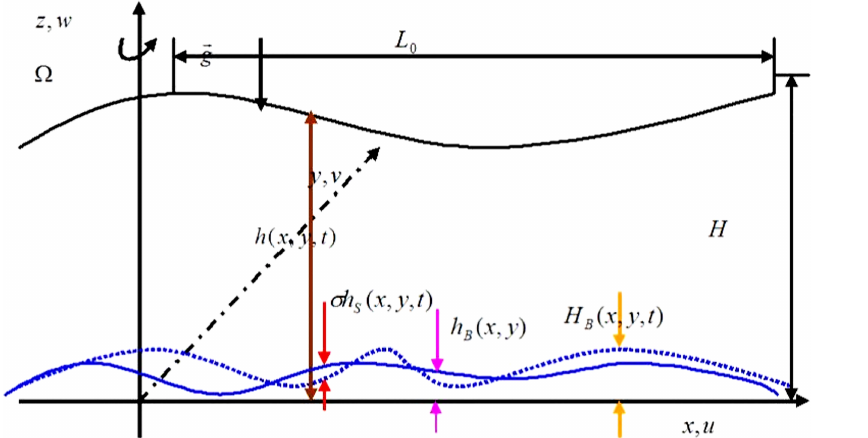
Fig 1. Conceptual diagram showing the change in height of the